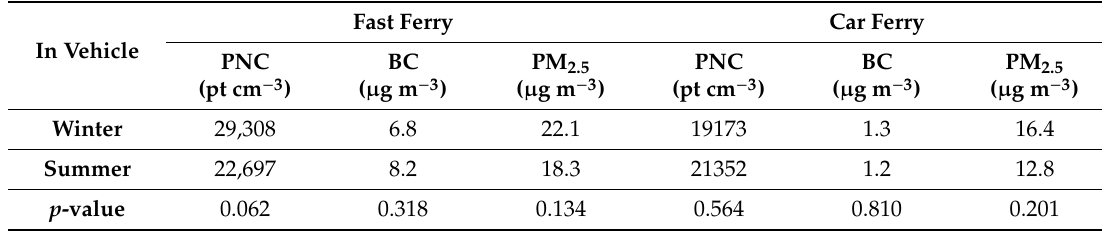
Table 3. In-ferry t -test results for the di ff erences between season (mean di ff erence = summer – winter).